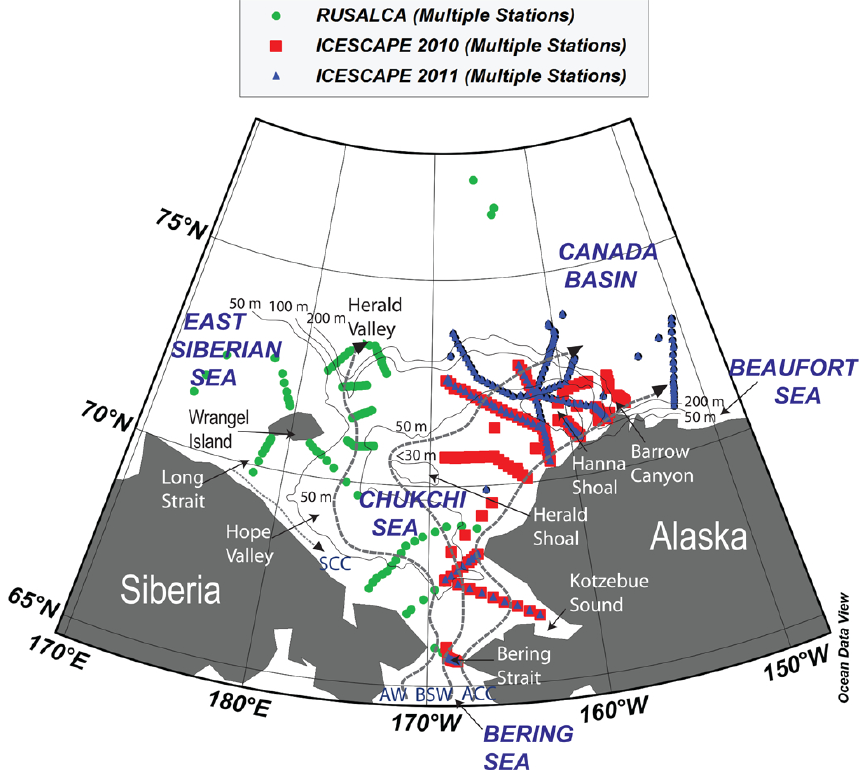
Fig. 1. Map of the western Arctic Ocean showing the stations occupied during the cruises according to the cruise year: RUSALCA 2009 (4–29 September 2009; green); ICESCAPE 2010 (18 June to 16 July 2010; red symbol) and ICESCAPE 2011(28 June to 24 July 2011; blue symbol). Approximate streamlines (bold dashed lines) of Alaskan Coastal Current (ACC), Bering Shelf Water (BSW) and Anadyr Water (AW) are shown. The intermittent flow of the Siberian Coastal Current (SCC) through Long Strait into the Chukchi Sea is also